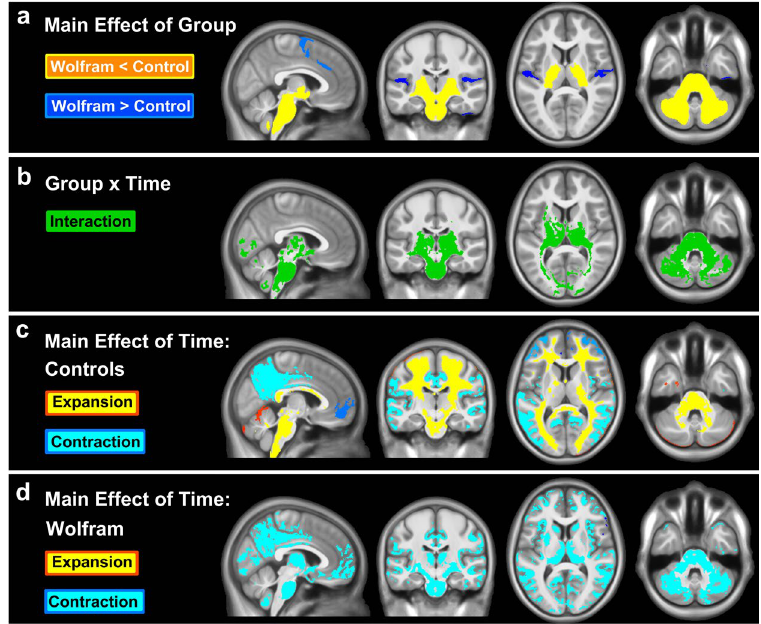
Figure 2. Clusters surviving FWE correction in each voxel-wise analysis at FWE p < 0.05. ( a ) Main effect of group : The Wolfram group has lower volume (yellow clusters) in multiple regions (e.g. brainstem, cerebellum, thalamus) and greater volume (blue) in relatively small portions of cortex compared to the control group. ( b ) Group × time interaction : Clusters where groups differed over time in volume (green) largely fell within the regions where the Wolfram group had lower volume than controls (yellow in a ). ( c ) Main effect of time within the control group : Volume increased in most white matter regions (yellow and red clusters) and decreased in cortical gray matter regions (turquoise and blue) over time, as expected. ( d ) Main effect of time within the Wolfram group : Volume decreased over time (turquoise) in many white and gray matter regions, and no increased volume was seen anywhere in the brain. Expansion = increase in volume over time; Contraction = decrease in volume over time.